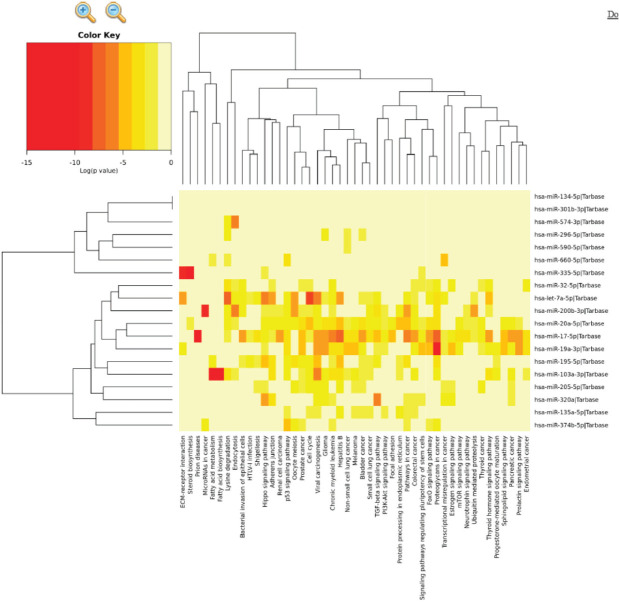
Pathway analysis of differentially expressed miRs between responders and non-responders at baseline. Diana miRPath version 3 KEGG pathways of 19 differentially expressed miR targets.